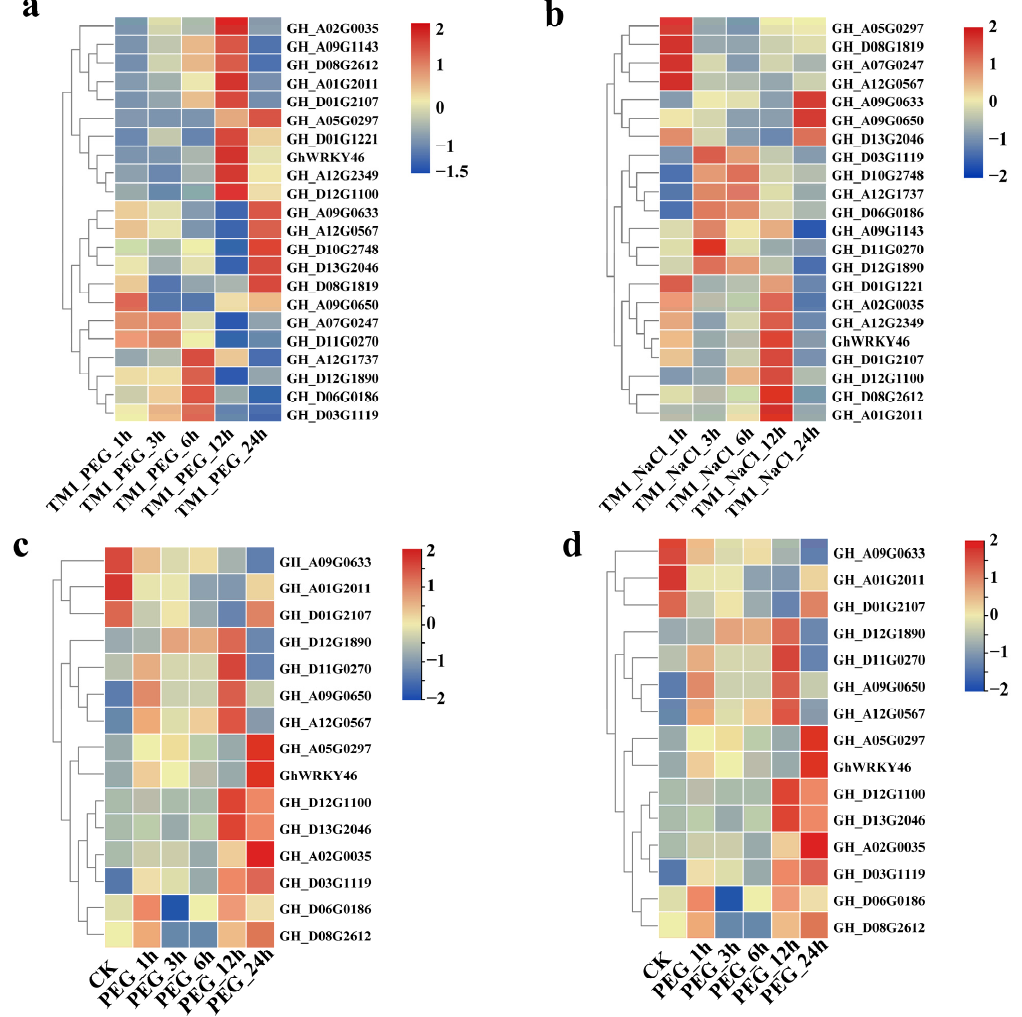
Figure 5. Expression profiling of 15 selected hub TFs; ( a , b ), the expression of 15 selected hub TFs in PEG and salinity in transcript profiling, respectively; ( c , d ), qRT-PCR analysis of 15 selected hub TFs in PEG and salinity, respectively. GhUBQ7 served as the reference gene.